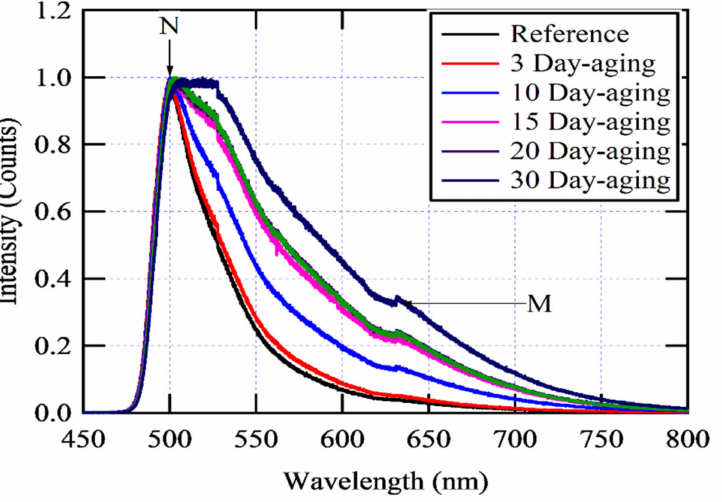
Figure 4. Normalized PL spectra of different transformer oil samples with different aging